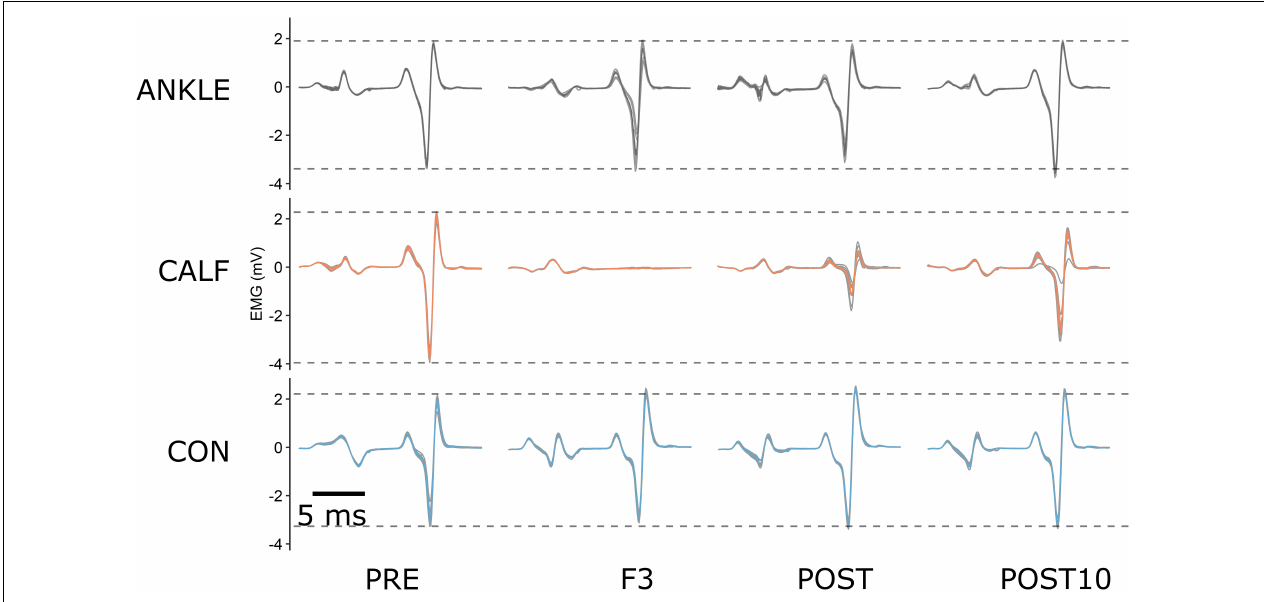
FIGURE 2 | An example of raw H reflex data for one representative participant at PRE, during F3, POST and POST10 time points. The colored lines represent the average of 9 consecutive signals at each time point. ANKLE, CALF, and CON conditions are represented by gray, orange and blue lines, respectively. Dashed lines represent baseline levels for each